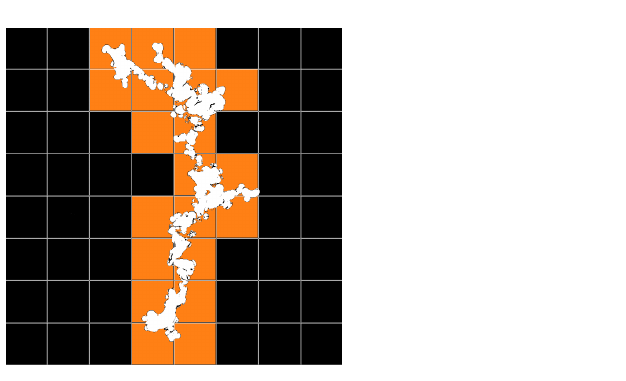
Figure 3. A TEM image processed in ImageJ after the Box-Grid Method was carried out.